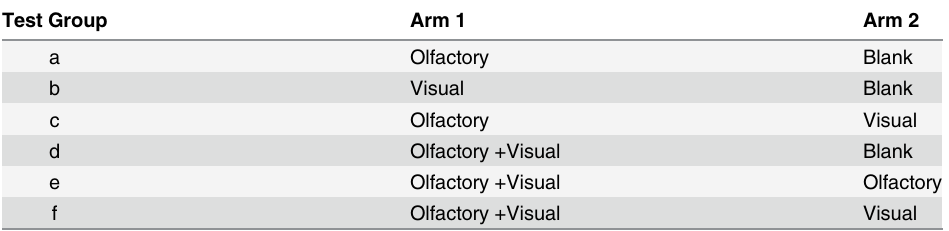
Table 1. Compound conditioning experimental test groups. Each group differs only in stimulus presenta- tion during testing. Each single stimulus is the presentation of the olfactory or visual stimuli alone. The com- pound stimulus is presentation of the olfactory and visual stimuli